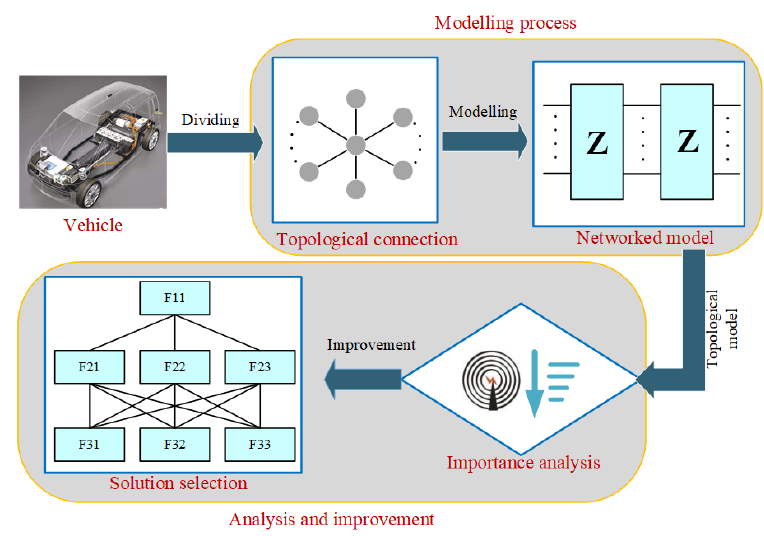
Figure 1. Model based analysis and improvement process.